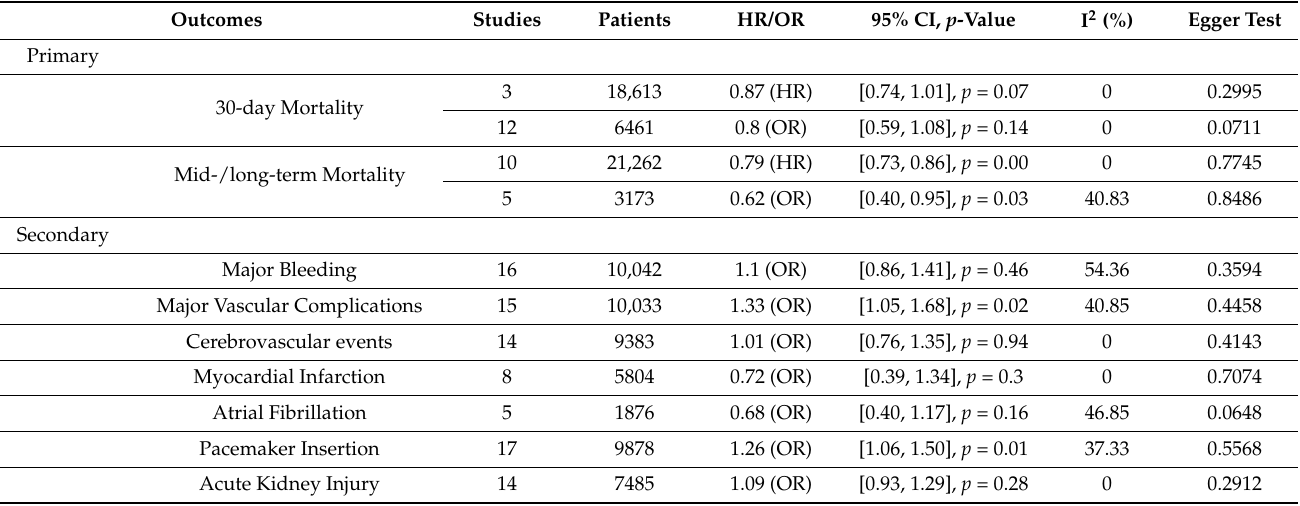
Table 4. Summary of meta-analyses for all outcomes in normal BMI versus patients with